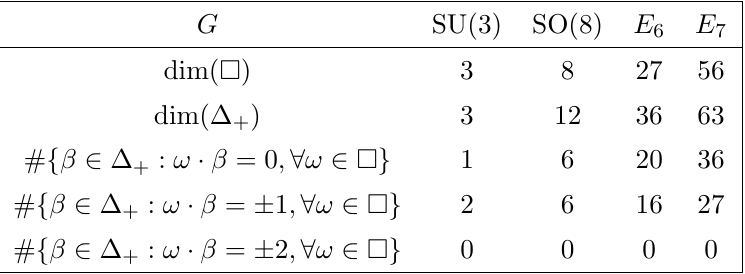
Table 4 . Distribution of positive roots with respect to product with weights in (cid:3) G